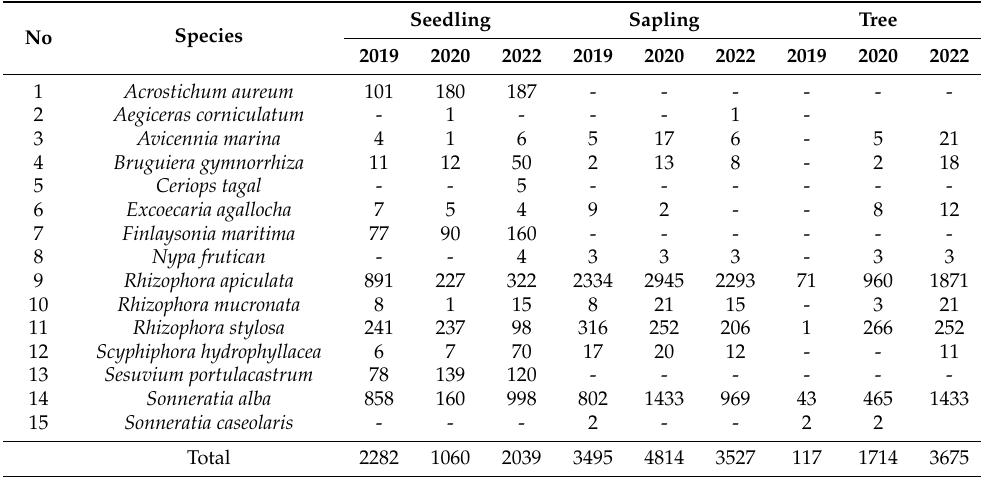
Table 5. Number of individuals observed in the restored areas planted with propagules using the census method from 2019–2022.